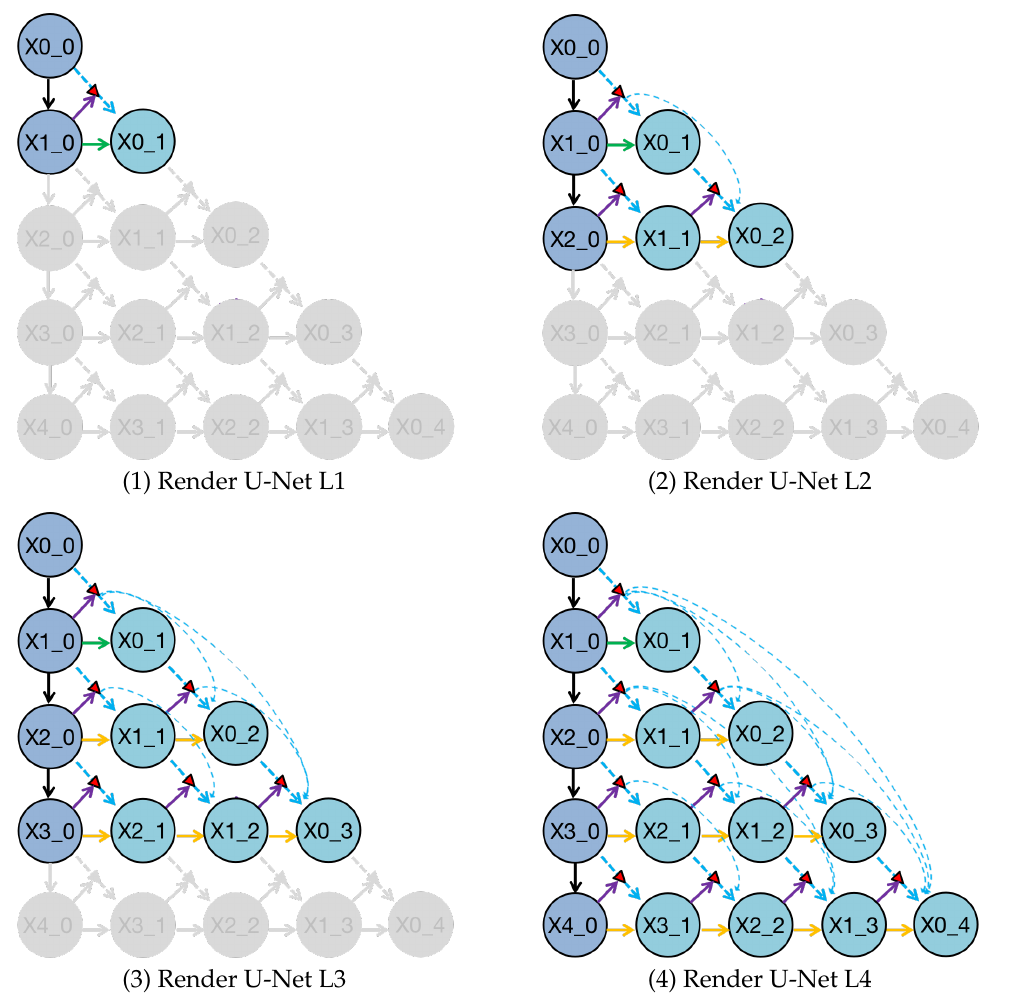
Figure 7. Deep supervision helps the trained Render U-Net pruning at different depths to obtain four sub-networks, which are represented by Render U-Net L1, L2, L3, and L4. The gray components in these sub-networks have been deleted during